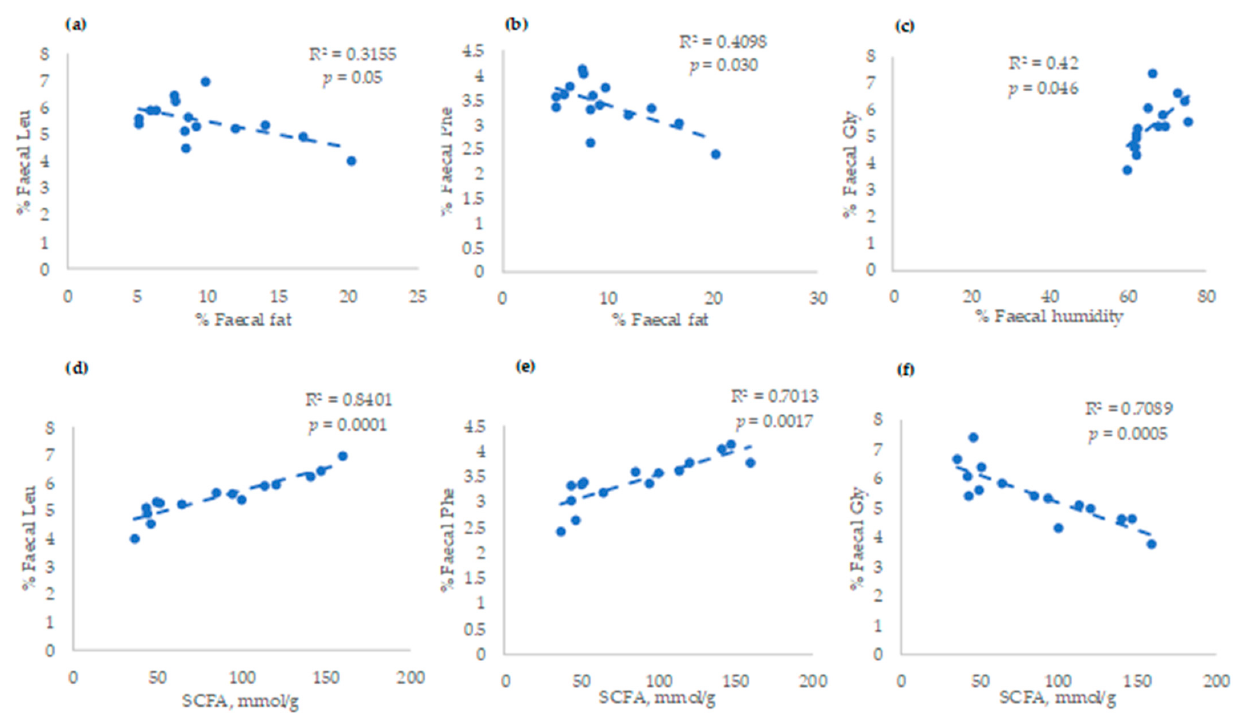
Figure 3. Linear adjustments between ( a ) % fat and Leu; ( b ) % fat and Phe; ( c ) humidity and Gly; ( d ) ∑ SCFAs and Leu; ( e ) ∑ SCFAs and Phe; and ( f ) ∑ SCFAs and Gly in faecal samples.